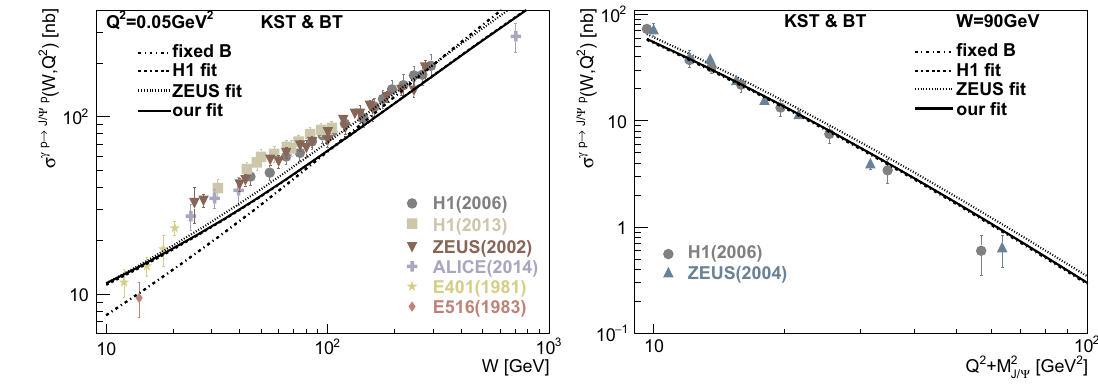
Fig. 7 The exclusive J /ψ electroproduction cross section as a function labeled as “our fit” is determined from Eq. (5.2) with the energy behav- ior at Q 2 → 0 found in Table 1 and indicated there as “this work”. The of c.m. energy W at fixed Q 2 = 0 . 05 GeV 2 (left panel) and the scaling variable Q 2 + M 2 results also incorporate the Melosh spin rotation effects. The data are at fixed W = 90 GeV (right panel). The model J /ψ provided by H1 [76,77], ZEUS [78,79], ALICE [83], E401 [84] calculations were performed with the J /ψ wave function, obtained by using the BT potential [82], and with the phenomenological KST dipole cross section [15]. Here and below, the Q 2 -dependent slope parameter